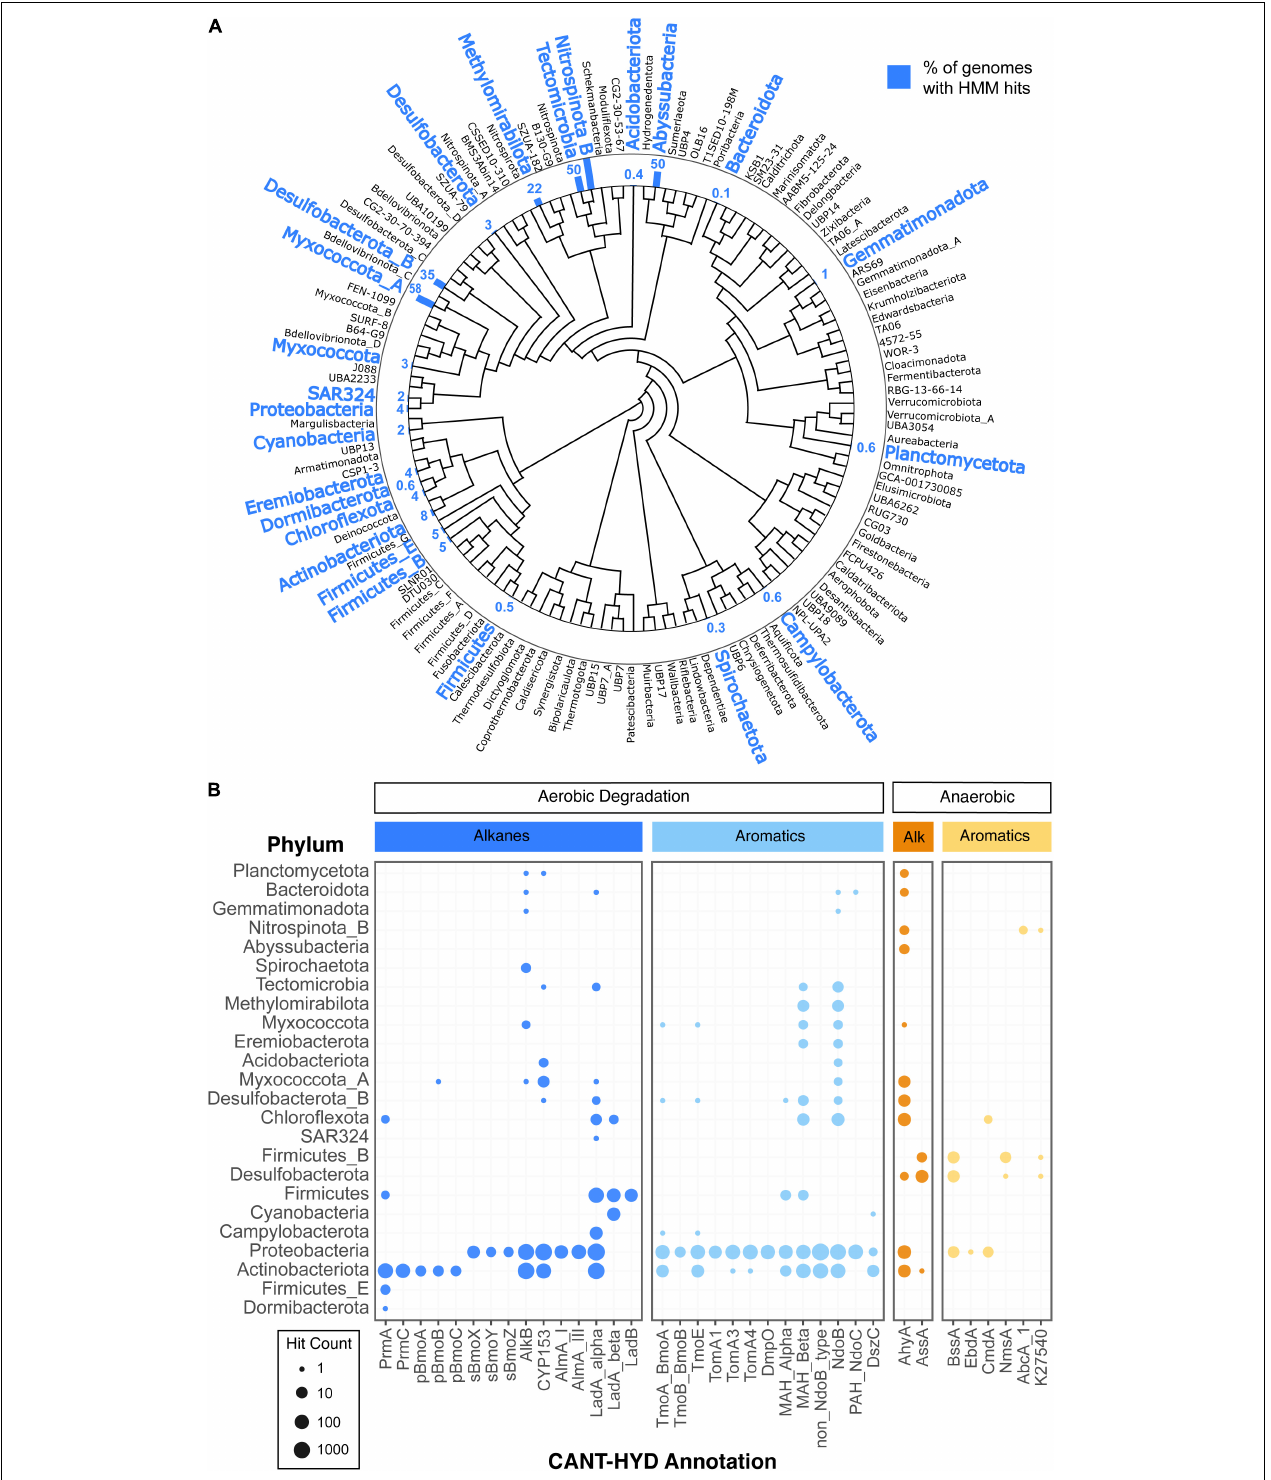
FIGURE 4 | Diversity of hydrocarbon-degrading bacteria and archaea. GTDB representative genomes with CANT-HYD HMM hits shown on panel (A) the GTDB phylogenomic tree collapsed at phylum level. Phyla with genomes containing genes with a CANT-HYD HMM score greater than the noise cutoff are shown in blue. The corresponding bar and number indicates the percentage of the representative genomes in that phylum containing at least one hit to a CANT-HYD HMM. For example, Abyssubacteria contained two genome representatives in GTDB, and one of the genomes contained a high confidence match to a CANT-HYD HMM; thus, the bar shows 50%. (B) Distribution and number of hits for each phylum in GTDB across the CANT-HYD HMMs.